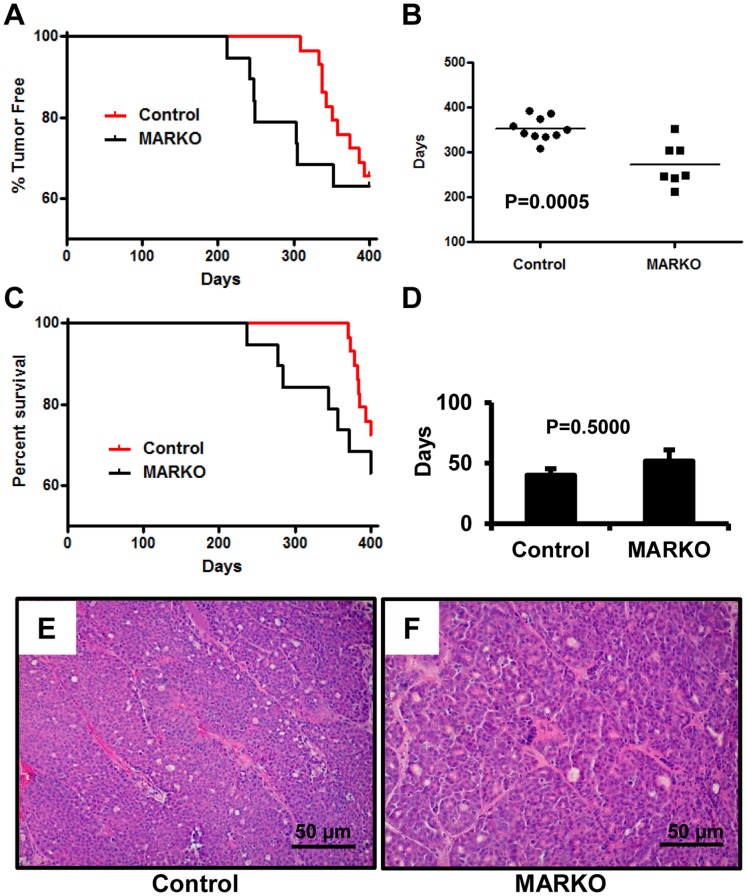
MARKO mice show an earlier onset of breast tumors in MMTV-NeuNT mice.A. Mice were examined two to three times per week starting at 6 months for the presence of palpable tumors. Age of incidence was recorded as the first day at which a palpable tumor was detected. Percentage of tumor free mice was plotted versus the age of the mice in days. Hazard ratio = 0.2340 and 95% CI ratio of = 0.06054 to 0.9047. B. Mean age of tumor incidence was calculated for tumor bearing MARKO (273+/−18.36 days, n = 7) and control (352.5+/−8.263 days, n = 10) mice, p = 0.0005. C. Survival of MARKO and Control MMTV-NeuNT females. Percentage of surviving mice was plotted versus age (p = 0.3499 at 400 days). Hazard ratio = 0.6023 and 95% CI of ratio = 0.2080 to 1.744. D. Average time in days between tumor detection and sacrifice, due to tumor burden prior to 400 days of age, p = 0.5000. Representative hematoxylin and eosin staining of Control (E) and MARKO (F) tumors. Scale bar = 50 µm.